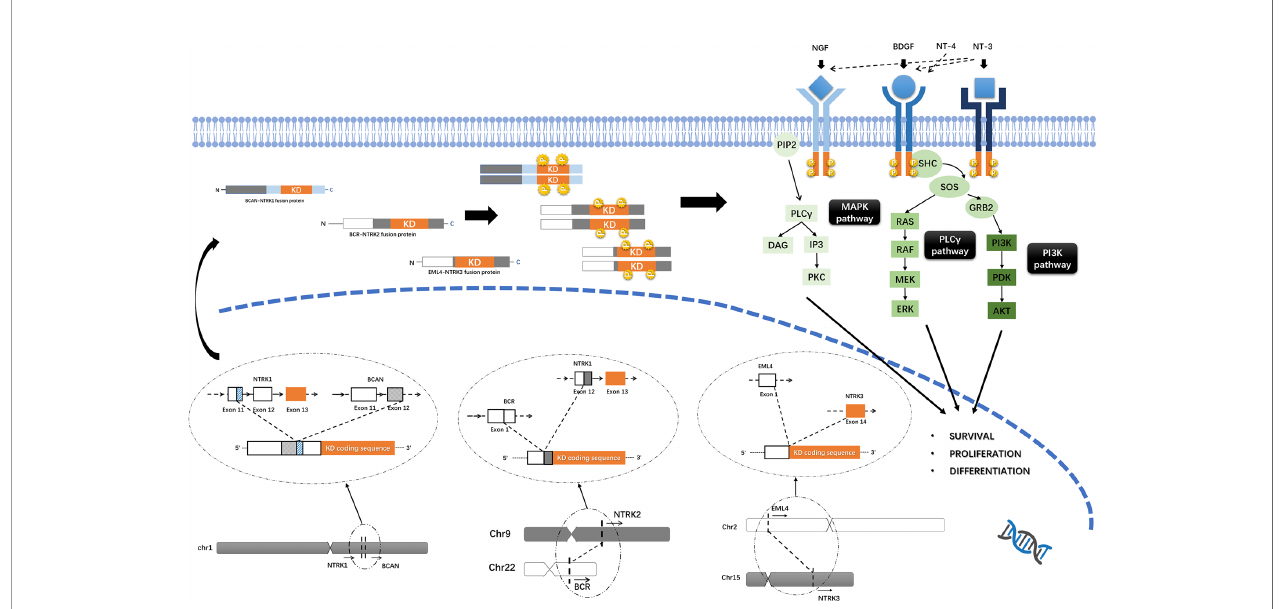
FIGURE 1 | Trks pathway and the oncogenic mechanism of NTRK fusions. Trk proteins contain an intracellular tyrosine kinase domain and promote cell proliferation and survival through downstream MAPK/ERK, PLC g /PKC and PI3K/AKT pathways. Functional Trk-fusion proteins contain a complete tyrosine kinase domain, and the partner gene is expressed in a homodimer, which induces ligand-independent activation of the tyrosine kinase domain and upregulates downstream cancer-associated pathways. The mechanism of NTRK fusions, for example, BCAN-NTRK1 (19), BCR-NTRK2 (15), and EML4-NTRK3 (25) gene fusions formation was